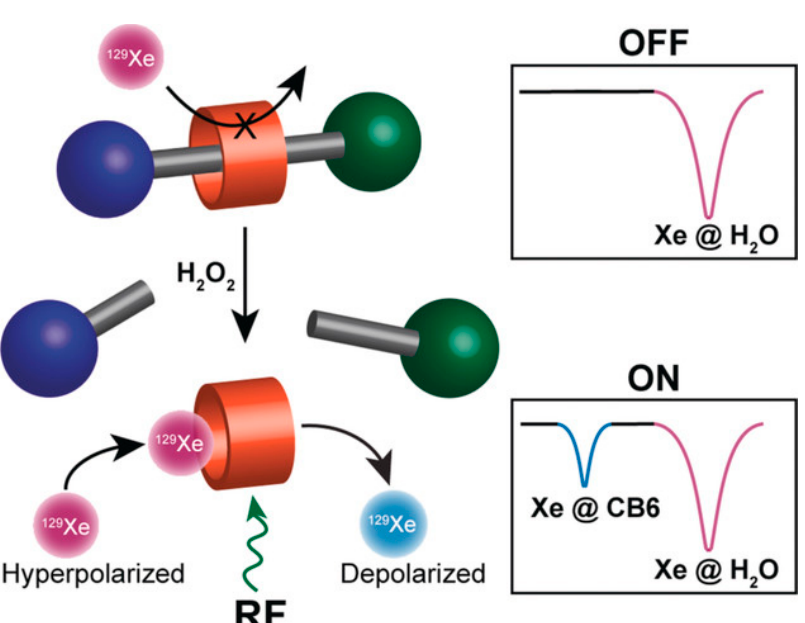
Figure 10. Principle of an activatable rotaxane system for HyperCEST detection. The inact rotaxane allows no access for Xe into the CB[6] unit and thus gives signal only for direct saturation of unbound Xe. The H 2 O 2 -cleavable unit enables a break of the axle and subsequent release of CB[6] to observe a CEST response from reversibly bound Xe. Reproduced with permission from [191], Copyright © 2019 John Wiley & Sons, Ltd (20 December 2019).